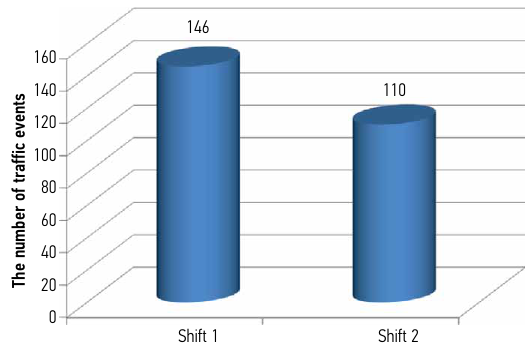
Fig. 4. The dependence of the number of traffic events on a driver’s